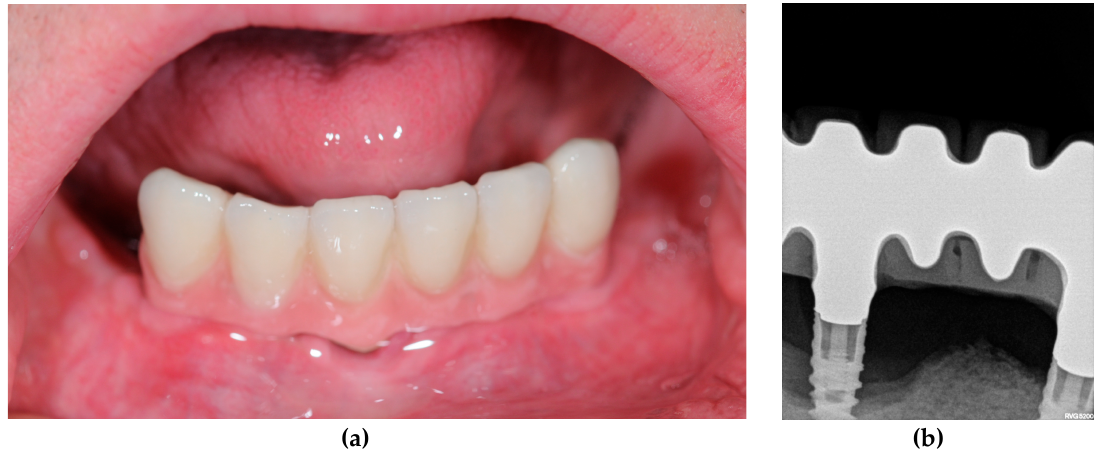
Figure 3. Patient 2 ( + PD + FI). ( a ) Clinical view. ( b ) Radiographical view. After the loss of all teeth due to severe periodontitis, four implants were placed, two of which are affected by peri-implantitis with severe bone loss at the end of the follow-up.